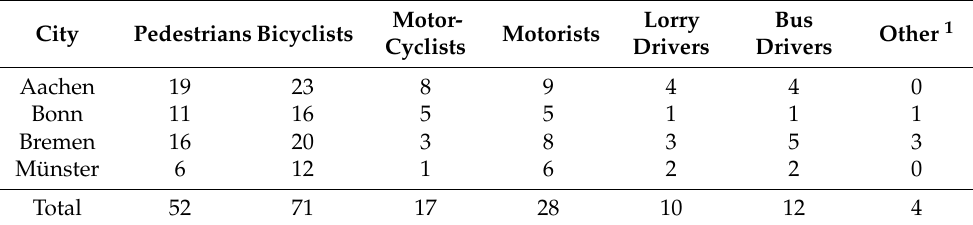
Table 3. Number of road users at risk per category and city ( N = 77 danger spots).